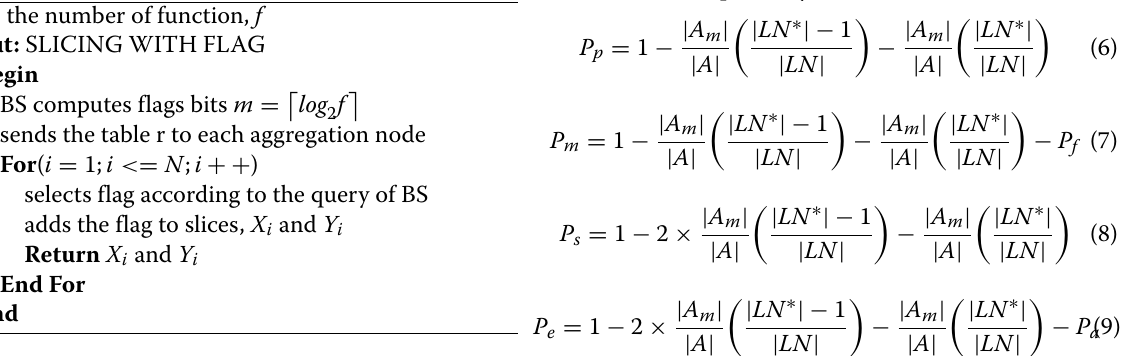
ALGORITHM II. MARK BIT OF